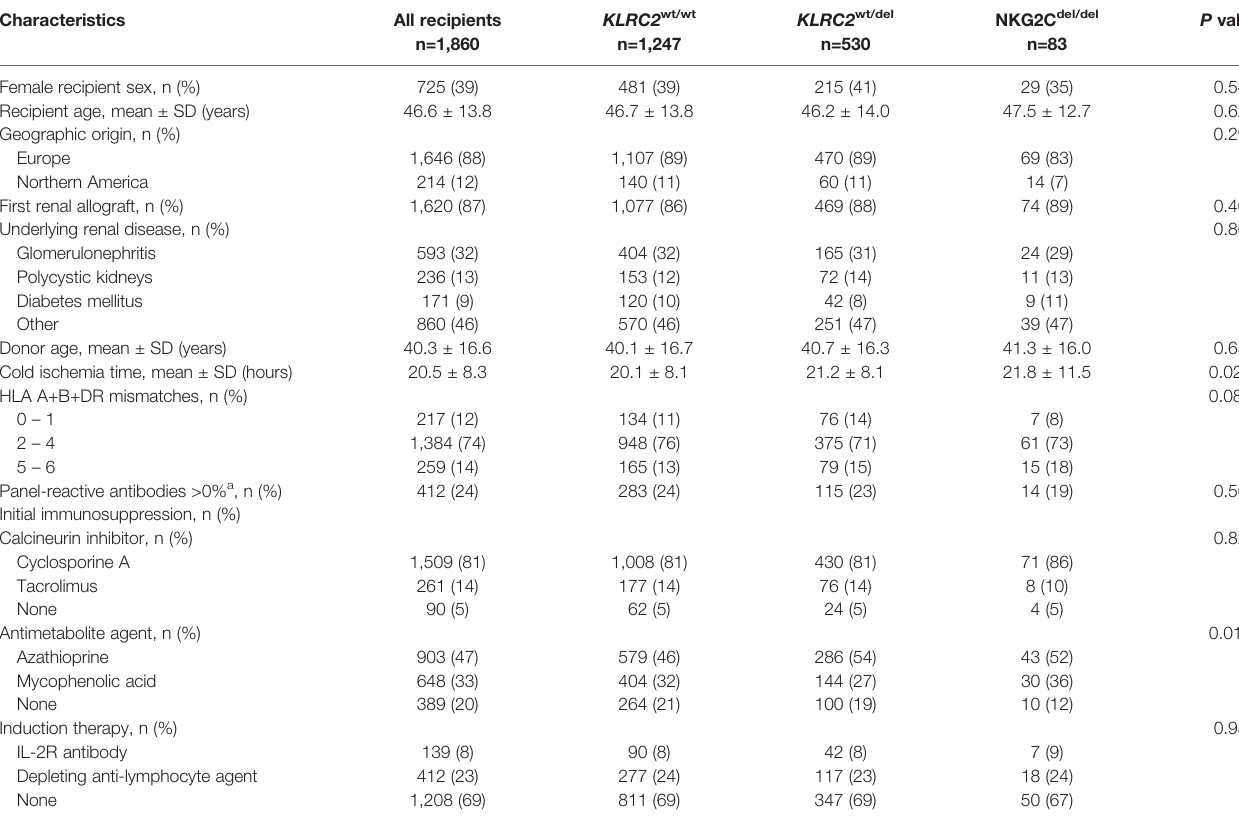
TABLE 2 | Baseline characteristics - cohort 2 (Collaborative Cohort Study, Heidelberg).